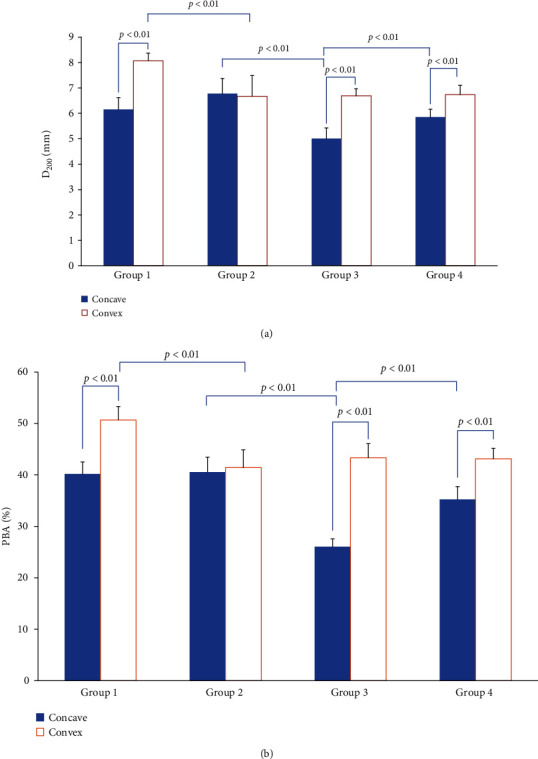
(a) Comparison of bilateral D200 between groups. (b) Comparison of bilateral PBA between groups.